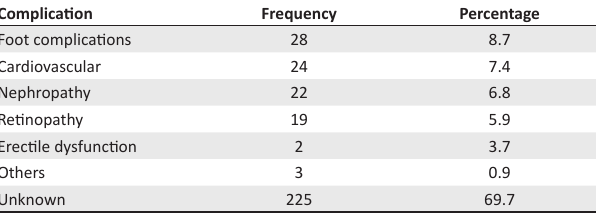
TABLE 3: Documented number of complications in reviewed files ( N = 323).